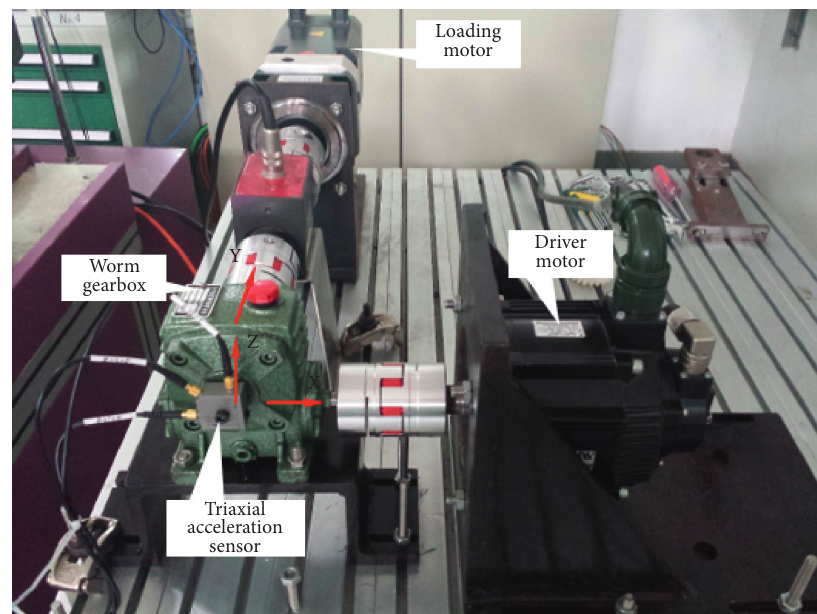
Figure 8: Worm gearbox test rig